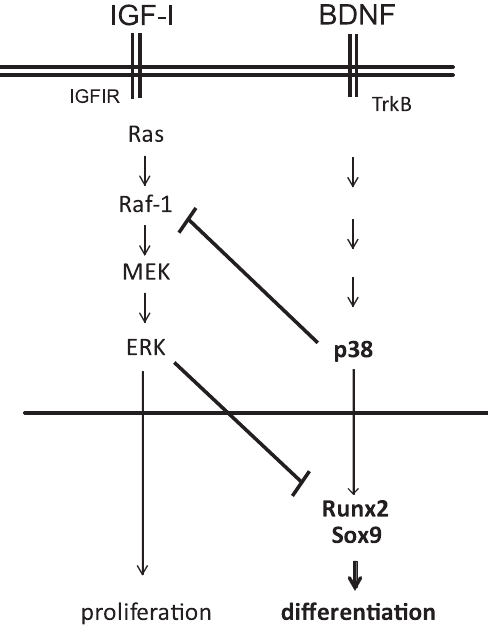
Figure 9. Proposed model of BDNF/TrkB regulation of chon- drocyte differentiation via p38 activation. Unopposed IGF-I action favors suppression of Runx2 and Sox9 expression and proliferation, whereas BDNF binding to TrkB results in increased p38 activity, decreased ERK activity, increased Runx2 and Sox9 expression, and ultimately hypertrophic